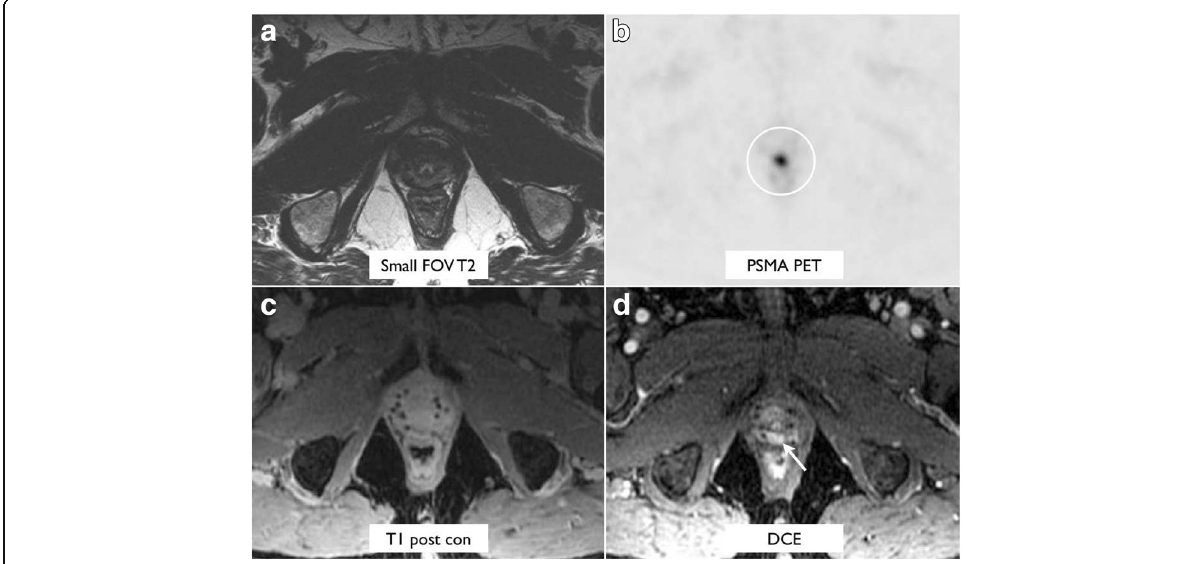
Fig. 4 A 62-year-old man with biochemical recurrence (PSA of 3.2), who had suspected PSMA-avid prostate bed recurrence measuring 1.0 × 0.6 cm after initial treatment with brachytherapy, seen on PSMA PET ( b ) and DCE images ( d ). The local recurrence was not seen on T2-weighted imaging ( a ), post-gadolinium T1-weighted imaging ( c ), or DWI (not shown due to artifact from brachytherapy